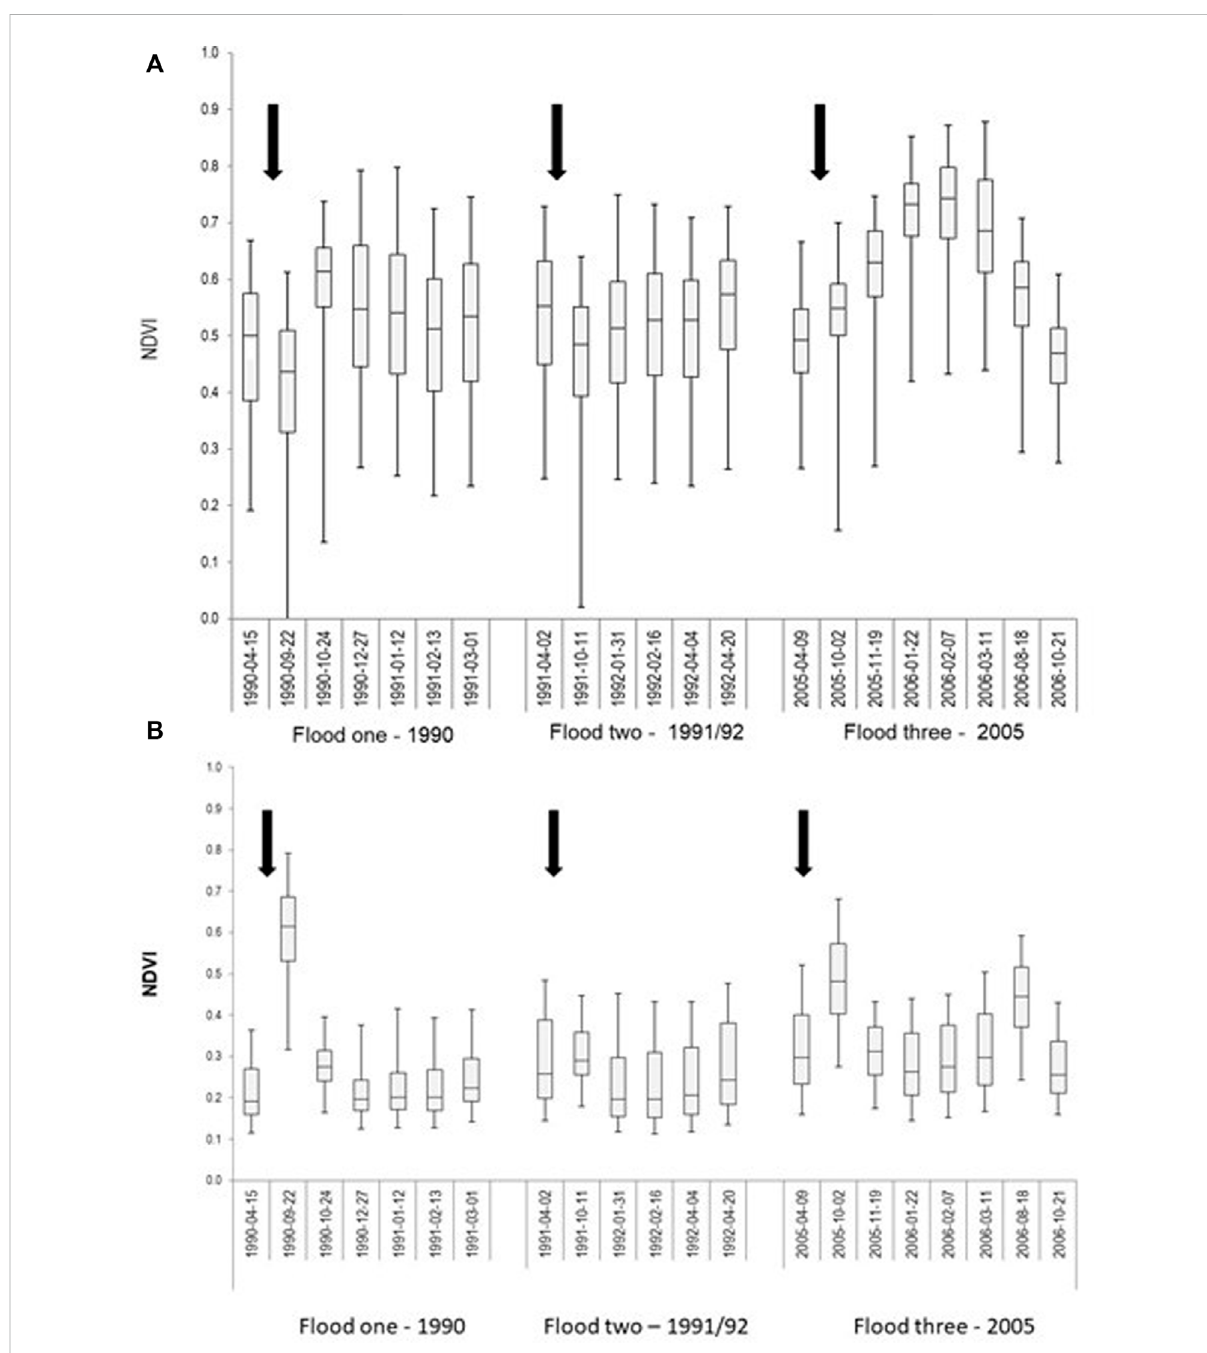
FIGURE 4 Floodplain vegetation (NDVI) response to surface water inundation during three fl ood events in the (A) inundated fl oodplain, and (B) non- inundated fl oodplain.Theboxwhiskerdiagramsprovidetheinter-quartilerange,meanandmedianvaluesaswellasthe2.5and97.5percentiles.The fi rst image of each sequence is the pre- fl ood condition, and the arrows indicate the commencement of fl oodplain inundation (modi fi ed from Shilpakar,